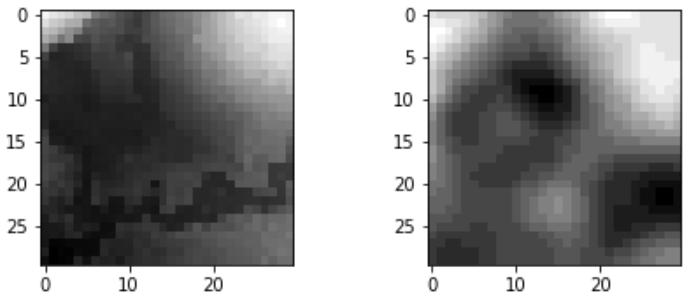
Figure 3. The terrain of a location of the Amazon forest as seen by the LiDAR sensor ( left ) and by the ALOS PALSAR ( right ), at the same resolution of 12.5 m. Height values increase from black to white. Obvious differences can be seen between the two